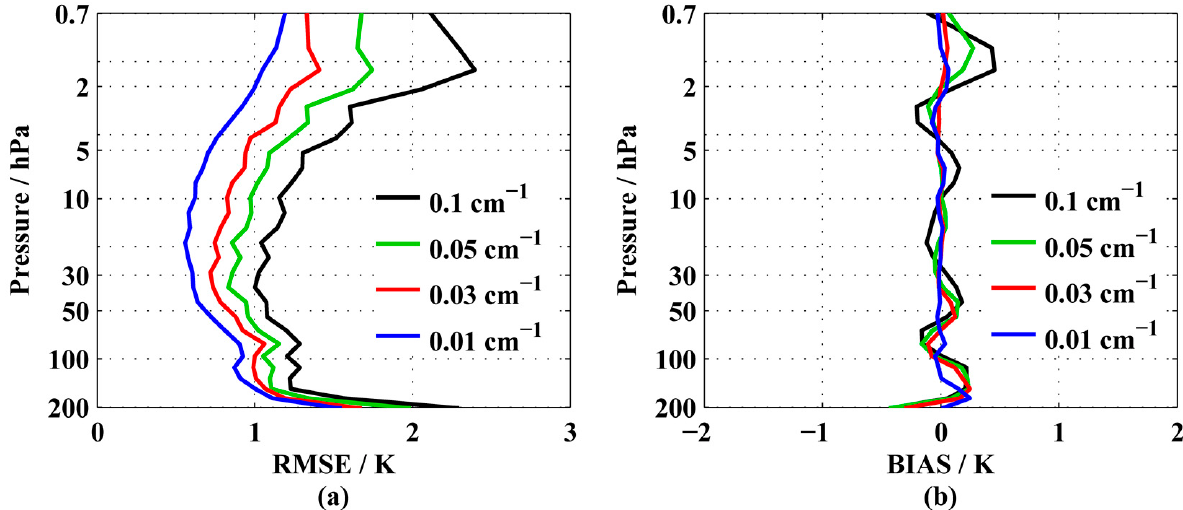
Figure 6. The retrieval results with di ff erent spectral resolutions, the same spectral range (16 cm − 1 ), and instrumental noise (0.1 K). ( a ) RMSE of temperature. ( b ) BIAS of temperature.